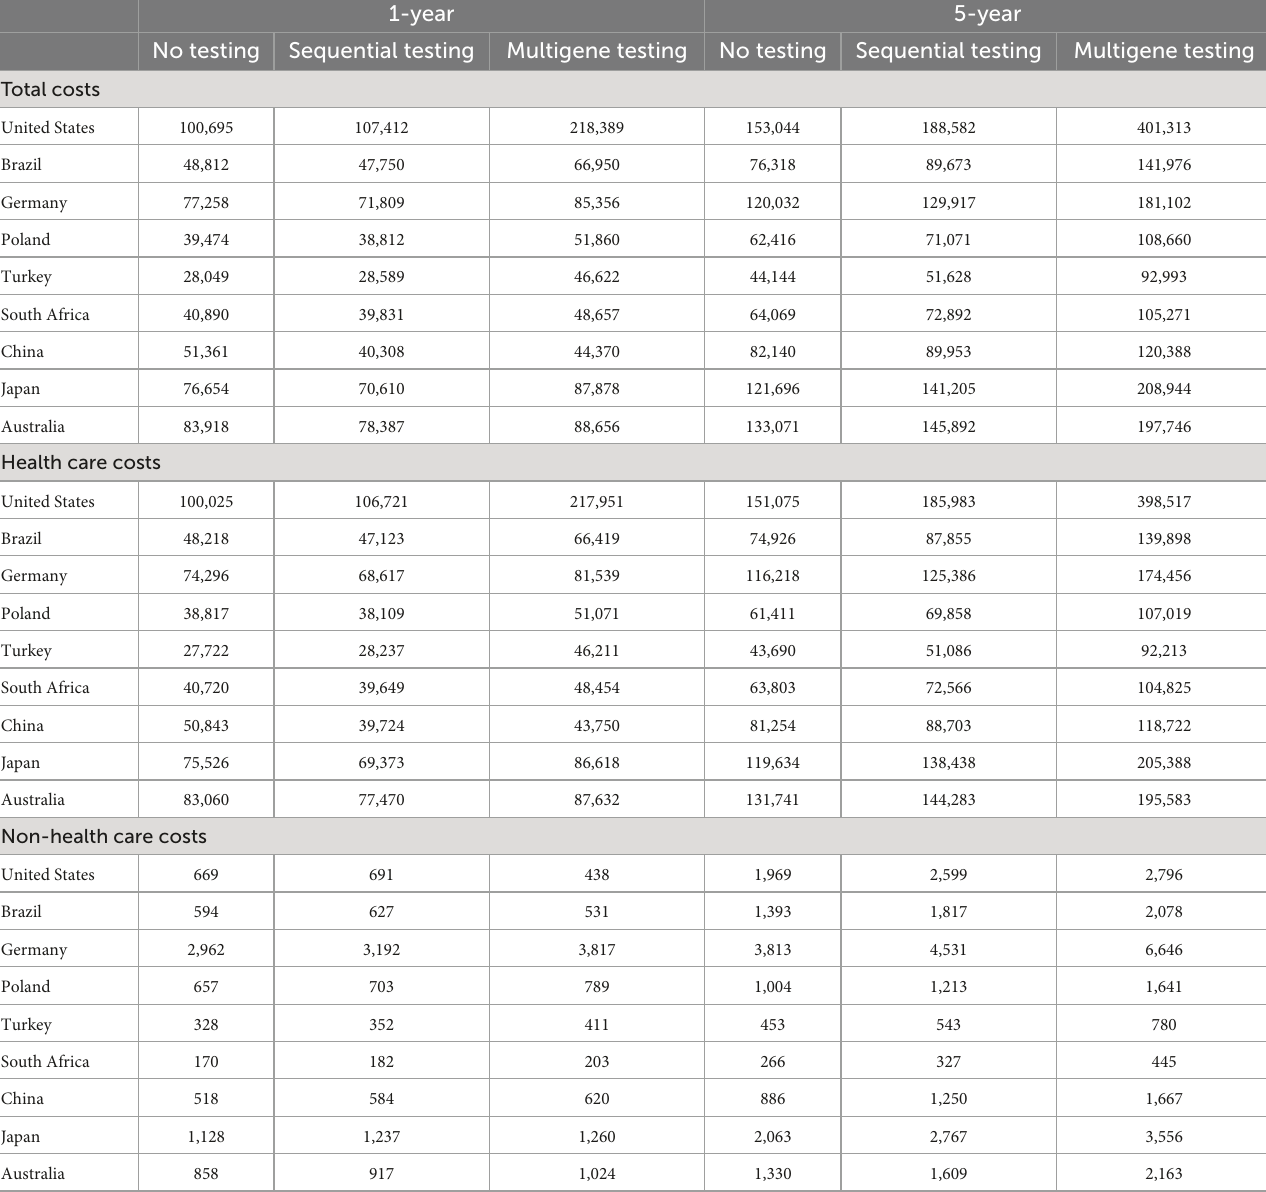
TABLE 2 Overall cost-related outcome measures per patient (all in